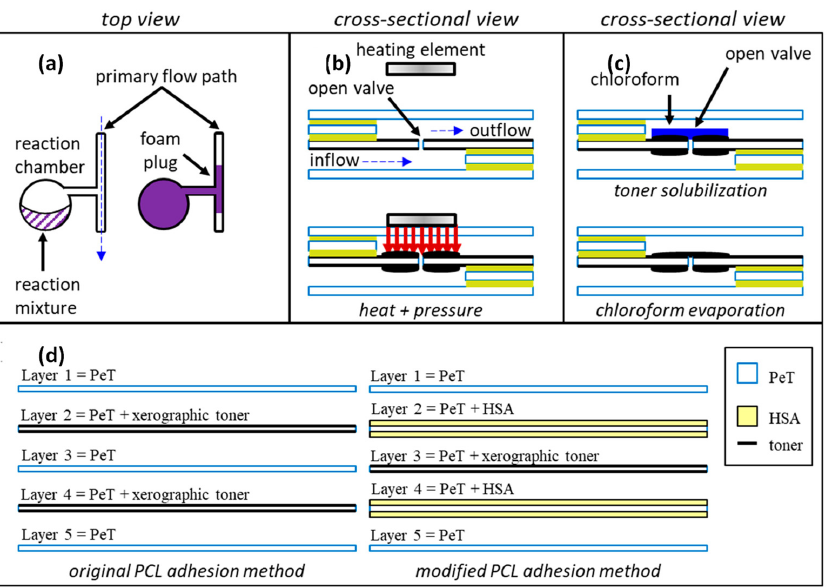
Figure 10. Schematic diagrams of the three types of microvalves described in [48]. Valve of type ( a ): Foam producing reagents are added to upstream reagent chambers within the device. Centrifugal pumping combines and mixes the two components. Upon mixing, the rapidly expanding polyurethane foam fills and blocks the target downstream channel. Valve of type ( b ): Heat and pressure are applied directly to a previously opened laser hole. Controlled compression and melting of the polymeric layers and adhesives form a permanent seal upon cooling. Valve of type ( c ): Chloroform is added to a previously opened laser patch, dissolving a portion of the xerographic toner. Rapid evaporation of the chloroform redeposits the toner into a uniform layer that covers the previously ablated laser hole. ( d ) Microdevices featured in this work consisted of five laminated PeT films that were prepared and assembled using the “print-cut-laminate” (PCL) method of fabrication. Cited from [47]. Permission was granted by the